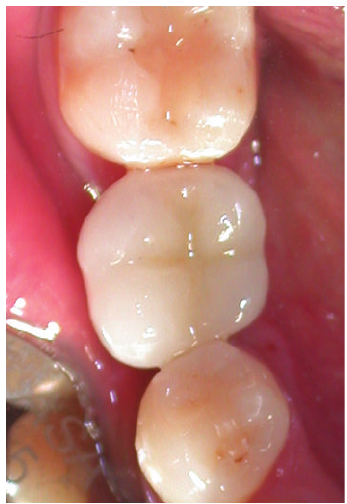
Figure 18: Provisional resin crown placement.